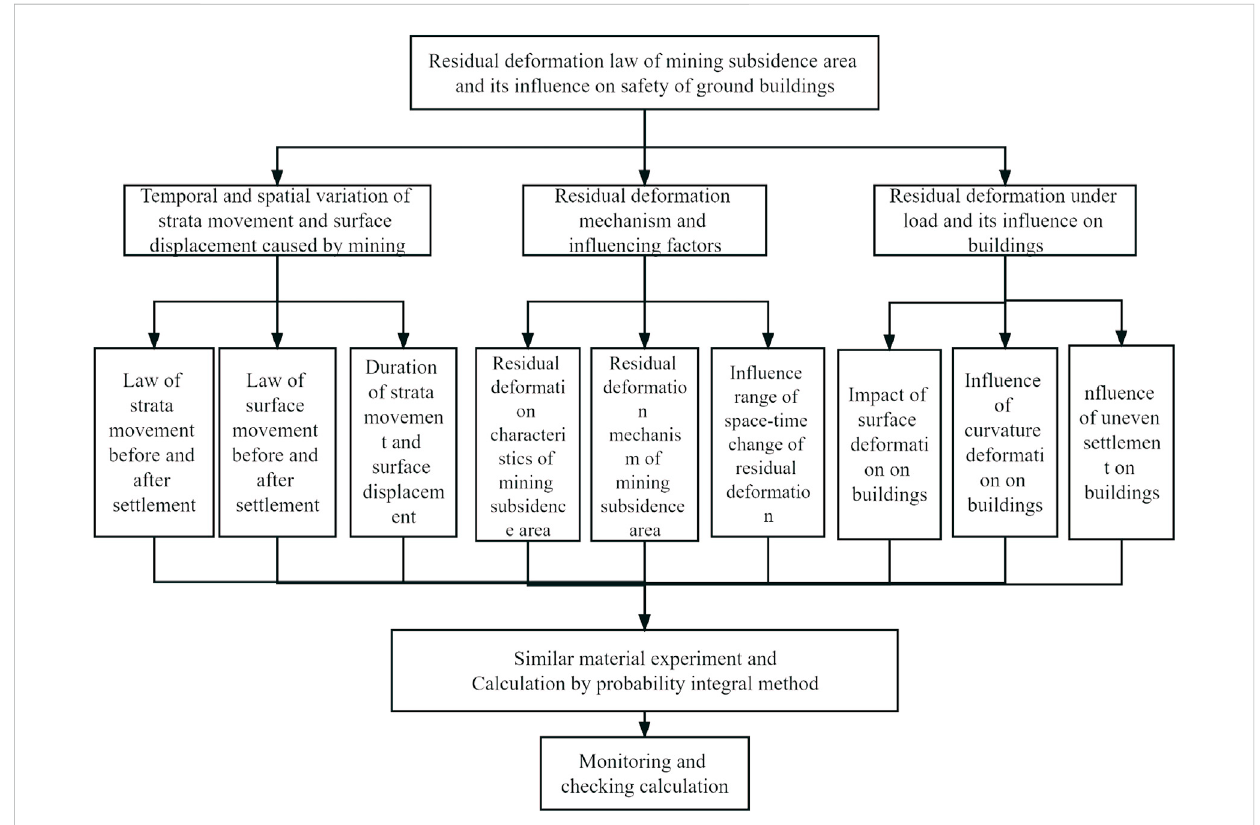
FIGURE 2 Flowchart of the